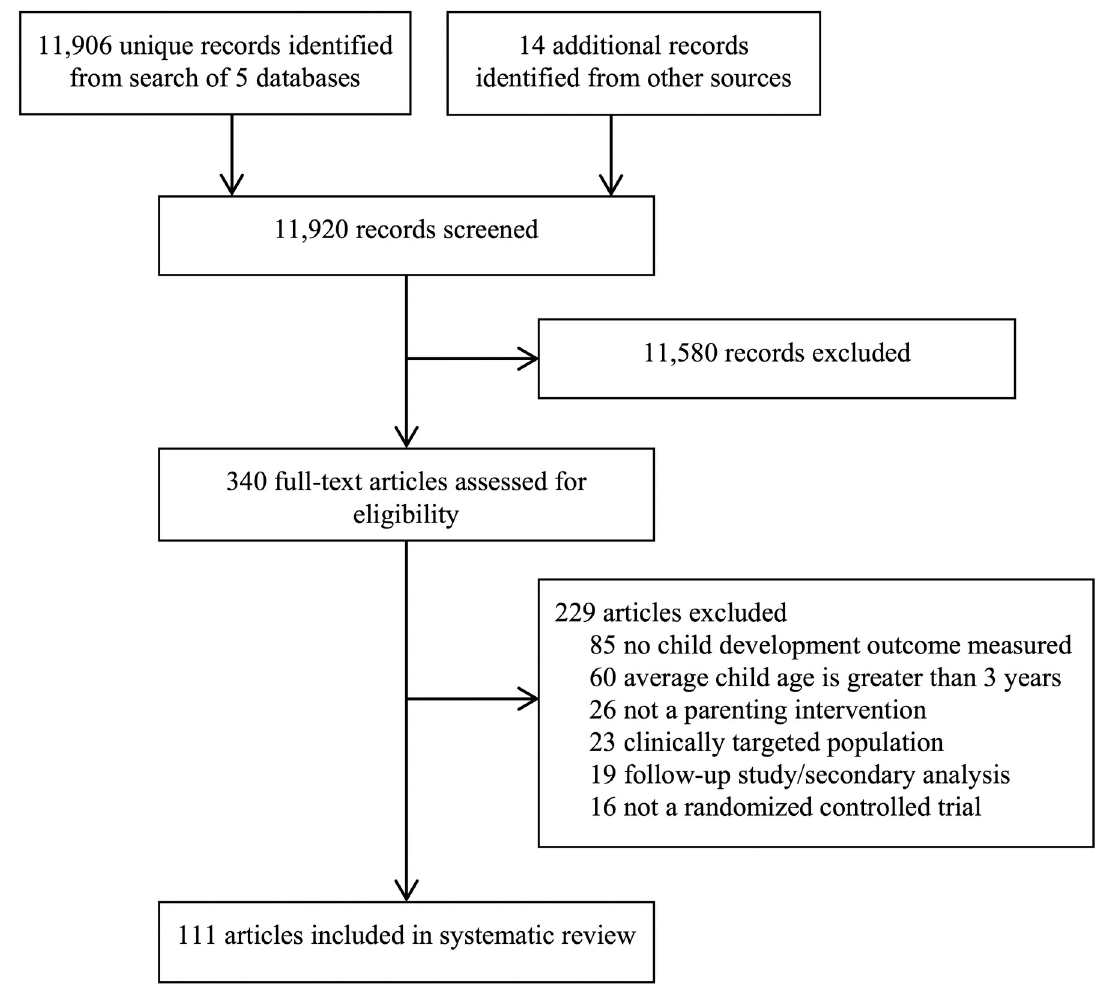
Fig 1. Preferred Reporting Items for Systematic Reviews and Meta-analyses (PRISMA) flow diagram of search results and included studies.